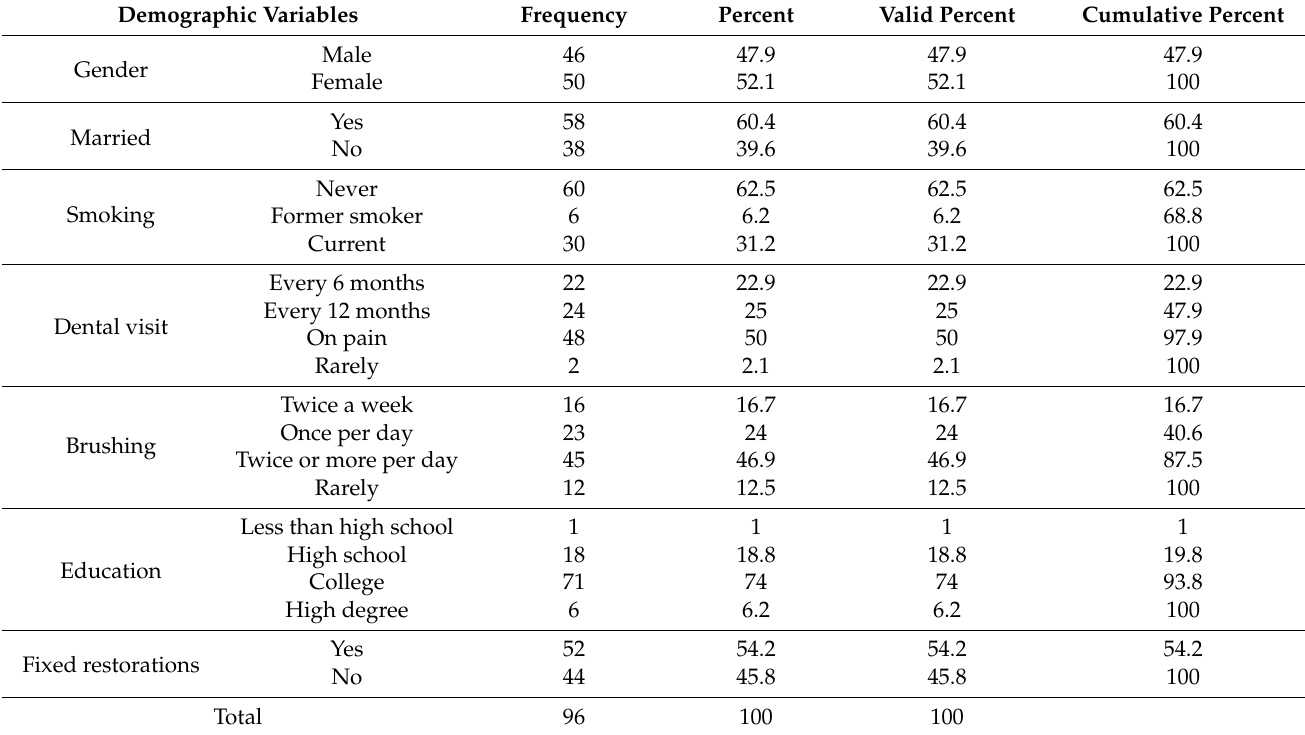
Table 1. Demographic details of the participating patients in the study ( n =